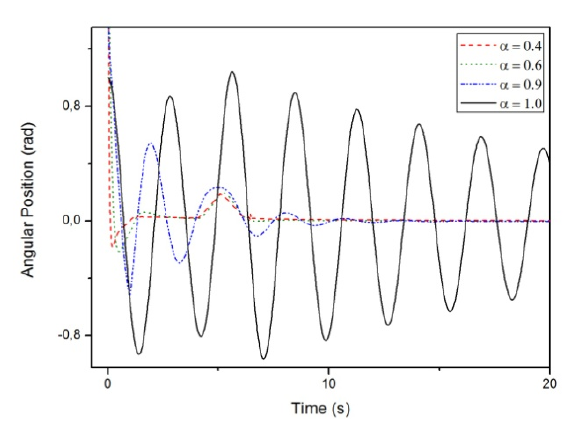
Figure 14. Time history (values of α ≤